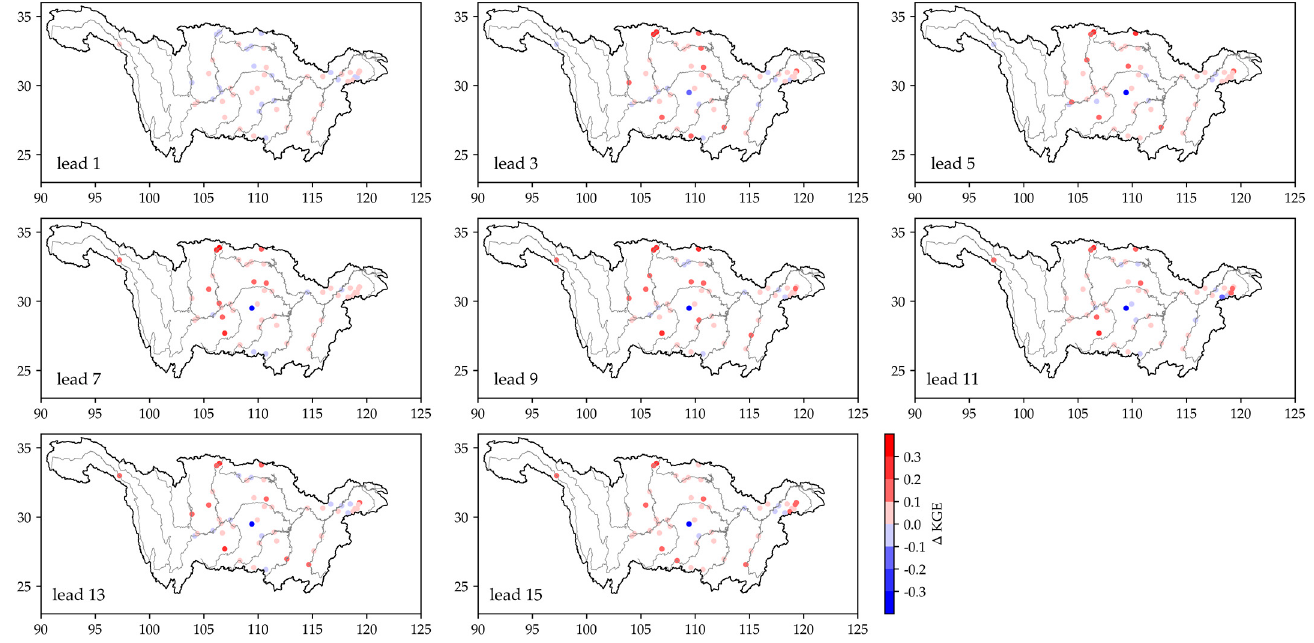
Figure 6. The relationship between the watershed area (ln km 2 ) and the LSTM_P precipitation fore- cast skill (KGE) at the lead times of 1–15 days.